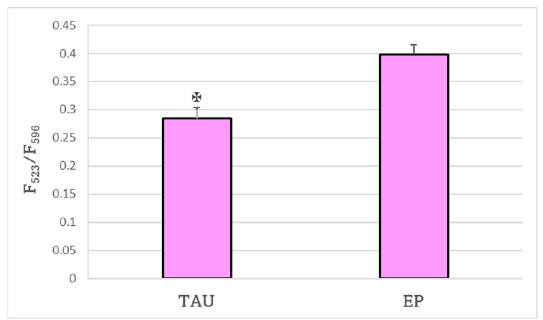
Figure 5. TAU cells had a significantly lower level of lipid peroxidation compared to EP control cells as estimated with the BODIPY C11 probe. The ratio of fluorescence measured at 523 and 596 nm after 24 h was used as a measure of lipid peroxidation. (cid:122) p < 0.05; n = 3. The mitochondrial mass was significantly increased in TAU cells with respect to EP cells (Figure 6A). The red to green fluorescence ratio, a measure of the mitochondrial inner membrane potential, was significantly lower in TAU cells than in EP cells (Figure 6B).